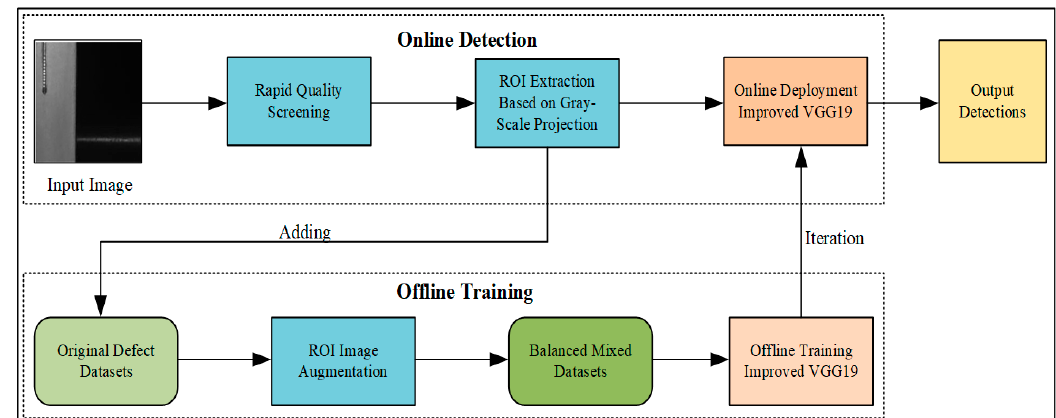
Figure 6. [35] Model outline diagram. Figure 6. Model outline diagram [35].